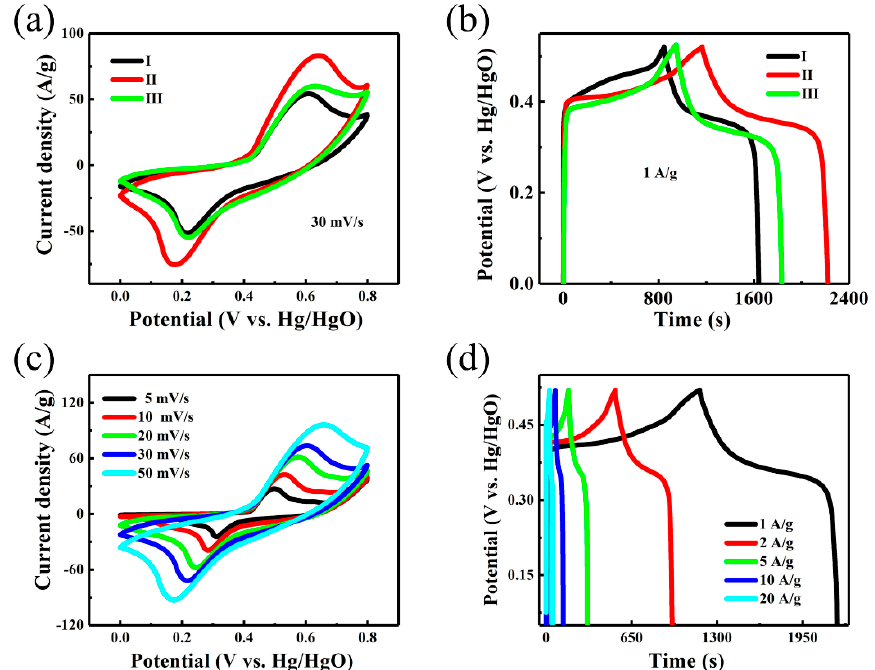
Figure 4. ( a ) Cyclic voltammetry (CV) profiles of Electrodes I, II, and III at 30 mV/s; ( b ) galvanostatic charge–discharge profiles (GCD) profiles of Electrodes I, II, and III at 1 A/g; ( c ) CV profiles of Electrode II at different sweep speeds; ( d ) GCD profiles of Electrode II at various current density.